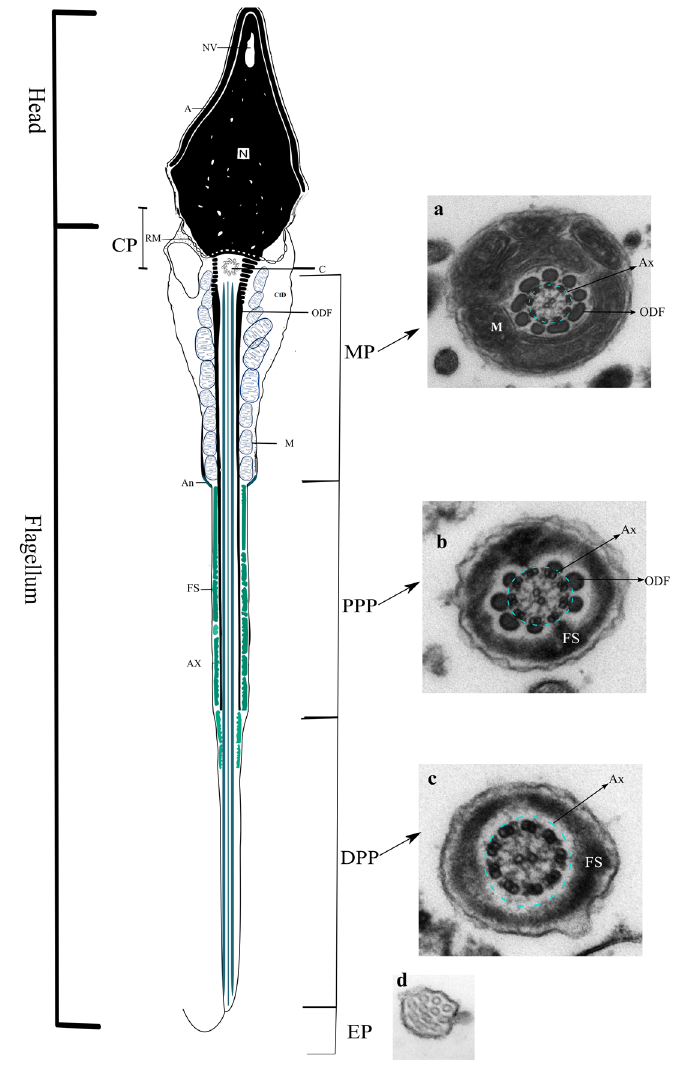
Figure 2. Schematic view of a human sperm cell and transmission electron microscope (TEM) images of a cross-section from the subregions of the sperm flagellum, which is subdivided into the connecting piece (CP), the midpiece (MP), the principal piece (PP; which can be further subdivided into proximal PP (PPP) and distal PP (DPP)), and the endpiece (EP). ( a ) Cross-section of the sperm MP showing the axoneme (Ax, light-blue dotted circle), the outer dense fibers (ODFs), and the mitochondrial sheath (M). ( b ) Cross-section of the sperm PPP showing the axoneme (Ax, light-blue dotted circle), the ODF, and the fibrous sheath (FS). ( c ) Cross-section of the sperm DPP showing the axoneme (Ax, light-blue dotted circle), and the FS. ( d ) Cross-section of the sperm EP, showing the axonemal disorganization that distinguishes this region. Legend: A, acrosome; An, annulus; C, proximal centriole; CtD, cytoplasmatic droplet; N, nucleus; NV, nuclear vacuole; RM, redundant membrane.